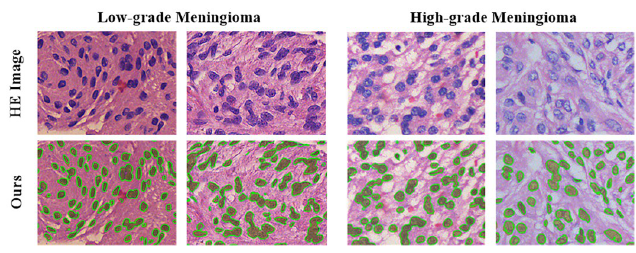
Fig 5. Nuclear area segmentation results of low- and high-grade meningioma images based on both the manual and proposed methods. where the olive areas are the ground truth, and the areas surrounded by thin green lines indicate our nuclear segmentation